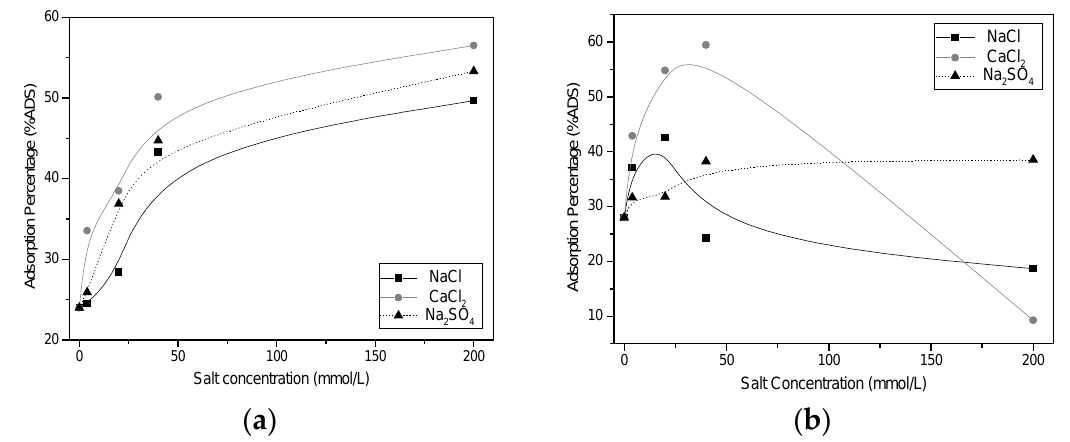
Figure 8. Salinity effect on the adsorption of phenol onto Sargassum sp. ( a ) and Chaetomorpha ( b ). Phenol concentration 100 mg/L; Initial solution pH: 10; masses of Sargassum sp. and Chaetomorpha : 40 mg and 100 mg, respectively.